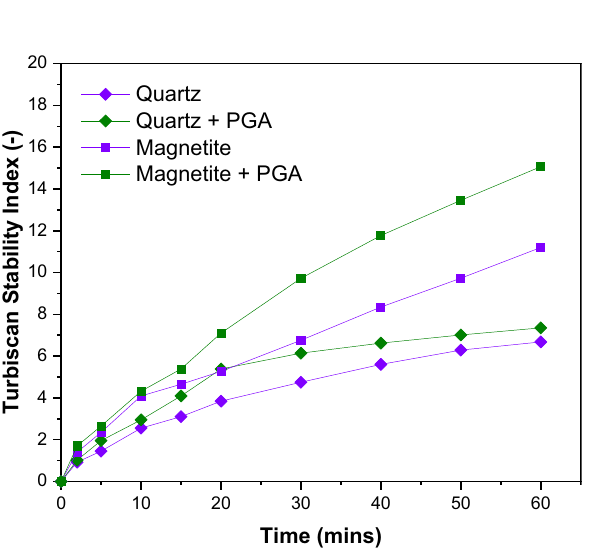
Figure 8. Stability of magnetite and quartz suspensions in the absence and presence of PGA (100 mg/L and pH